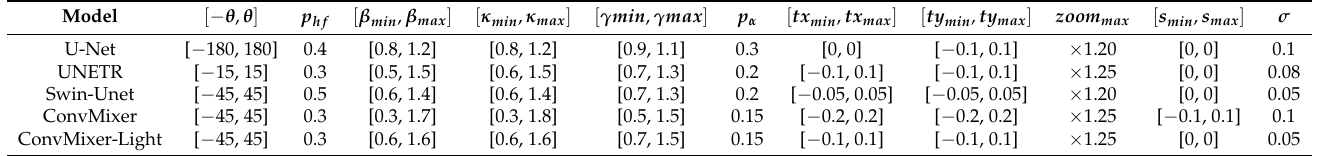
Table 2. Table summary of the hyperparameters used for data augmentation for each model.